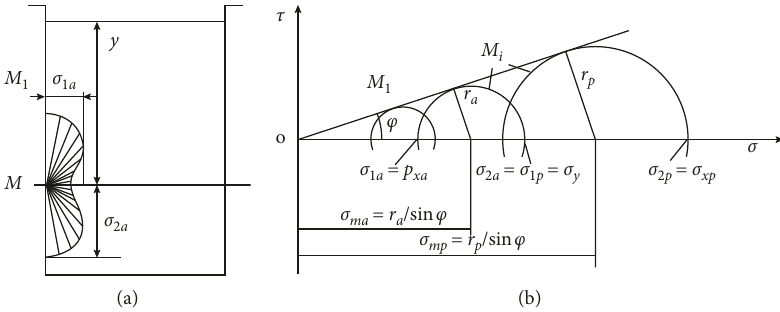
Figure 3: Horizontal lateral stress. (a) Active pressure (b) Mohr’s stress circle of lateral stress